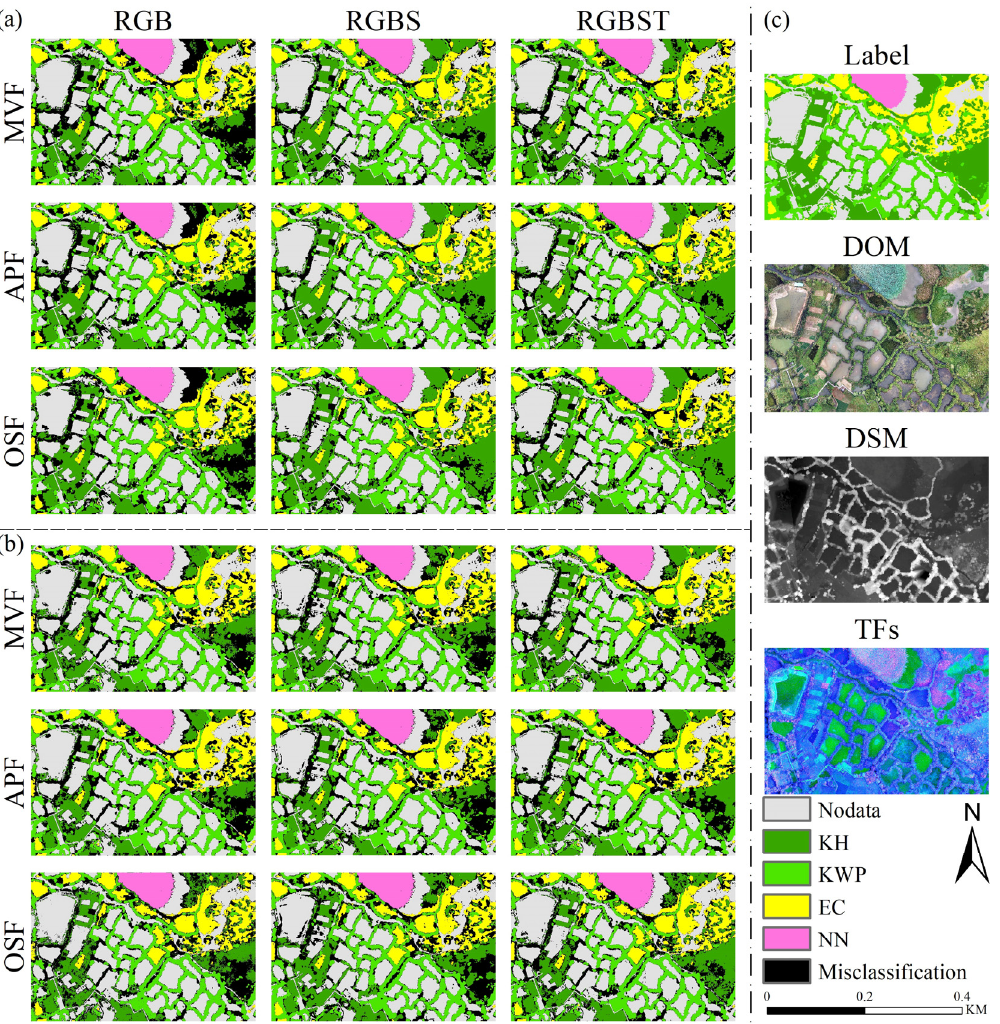
Figure 14. Classification results for karst wetland vegetation based on different image datasets. ( a ) OC-FCM, ( b ) MC-FCM, ( c ) semantic label and UAV data.